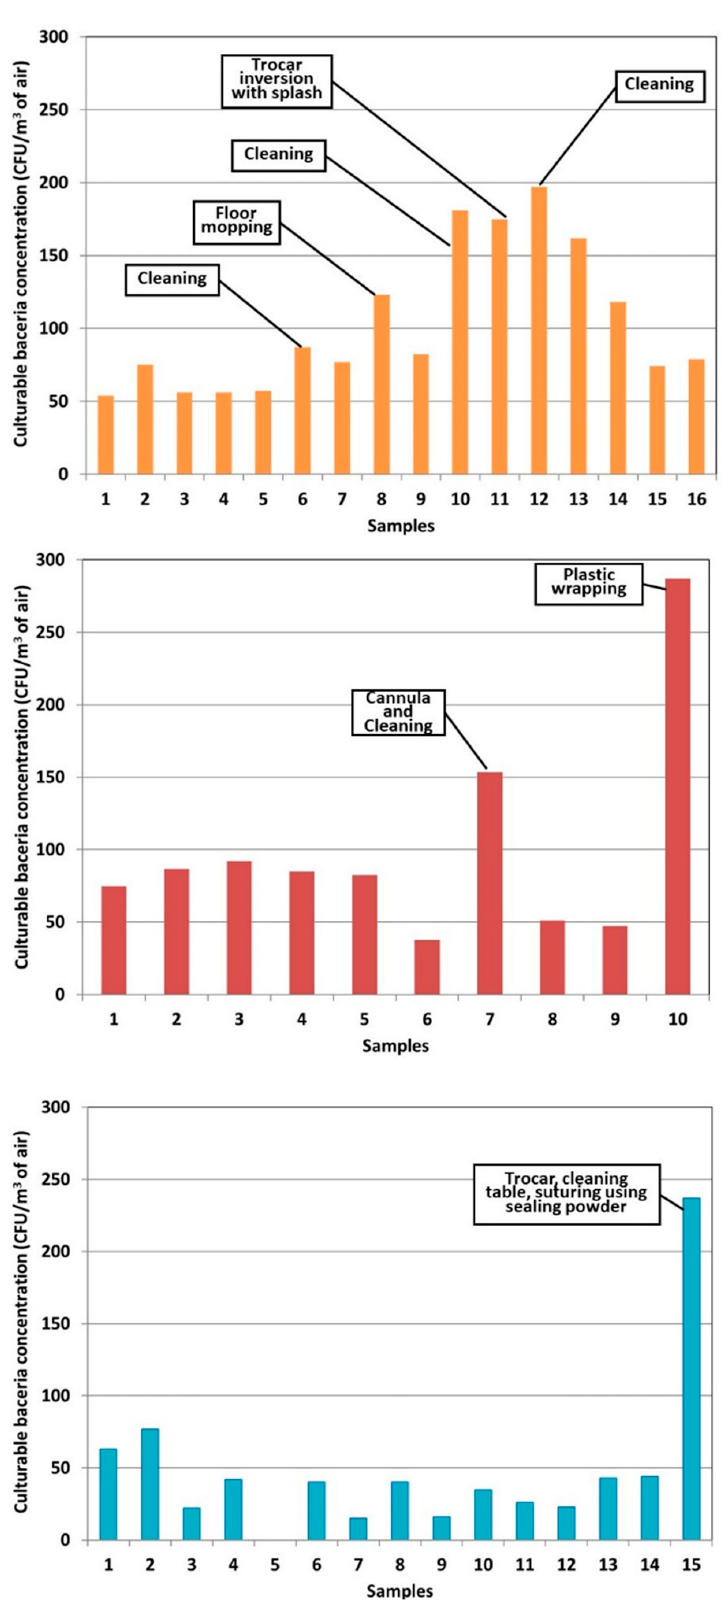
Figure 9. Concentration of culturable bacteria per cubic meter of air observed in Lab A ( top ) B ( middle ) and C ( bottom ) for 15 min sampling on TSA with 5% defibrinated sheep’s blood using the Andersen 6 stages impactor at a flow rate of 28.3 L/min. (CFU: Colonies forming units).